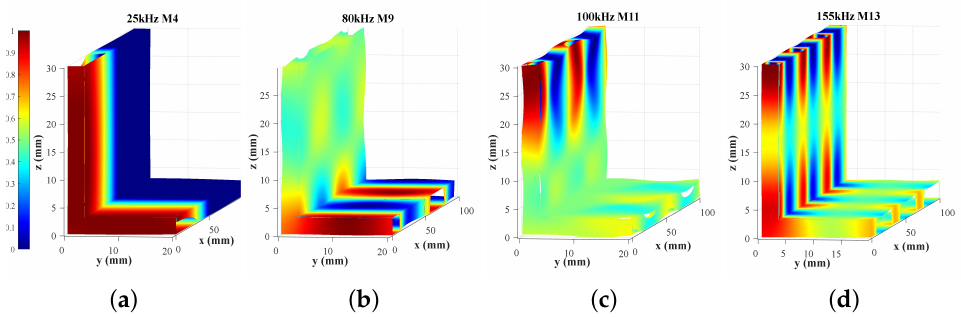
Figure 4. Normalized mode displacement shapes in the longitudinal x calculated by the SAFE method: ( a ) 25 kHz M4, ( b ) 80 kHz M9, ( c ) 100 kHz M11, ( d ) 155 kHz